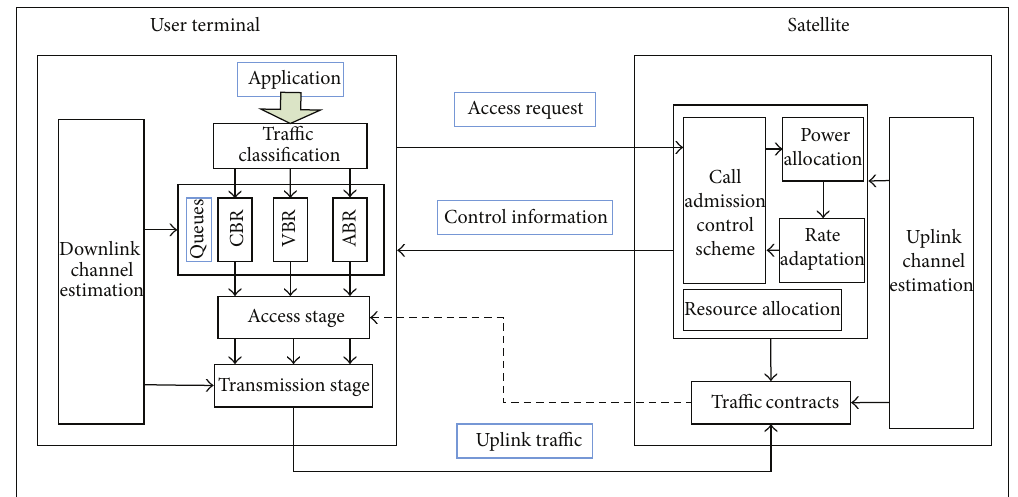
Figure 2: The framework of QoS guarantee mechanism.